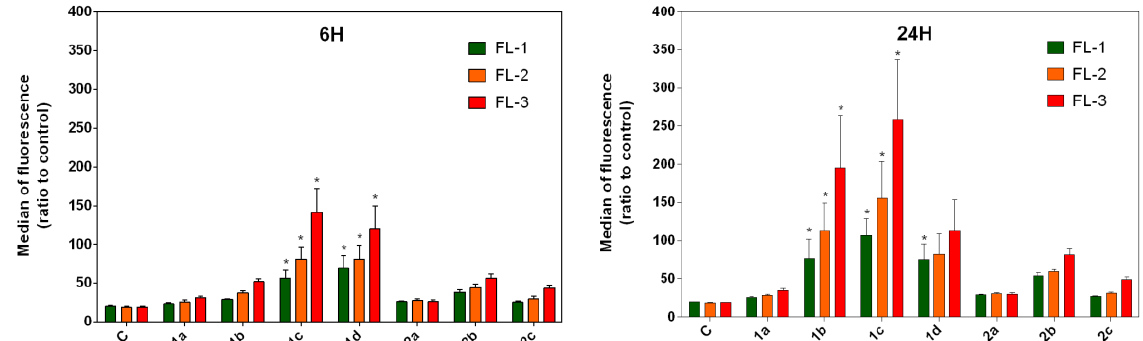
Figure 2. Flow cytometric analysis of intracellular level of derivatives 1a – 2c . Intrinsic fluorescence of compounds was detected after excitation at 488 nm and the emission was measured using a 530/30 nm band-pass filter (FL-1), 585/42 band-pass filter (FL-2) and 670 nm long-pass filter (FL-3). The results are presented as the mean values ± SD of three independent experiments; statistical significance (*): p < 0.05 for each experimental group compared to the untreated control.